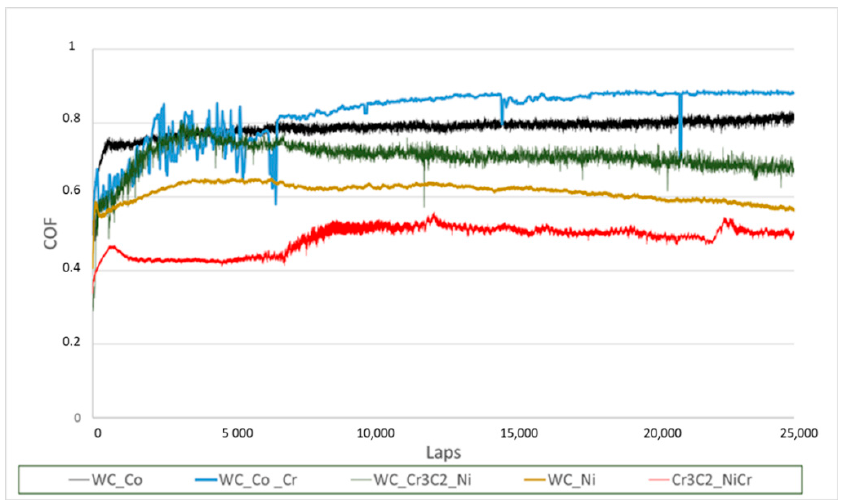
Figure 7. Scratch test results and their standard deviation.